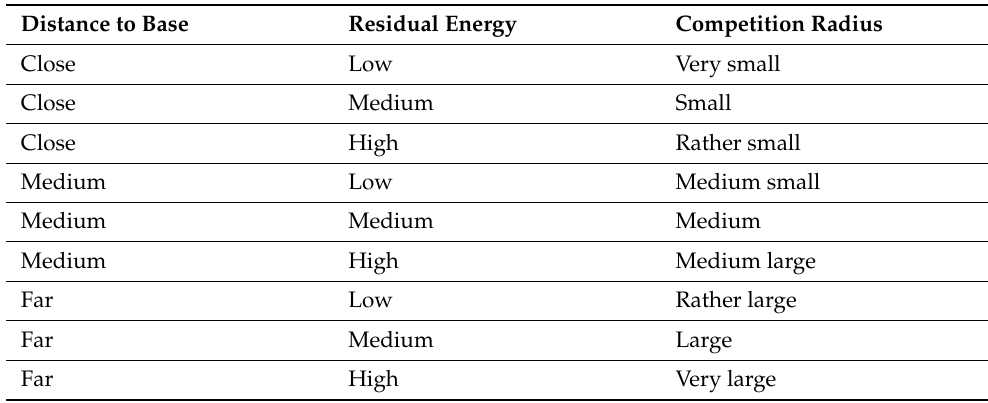
Table 6. If-then phase rules